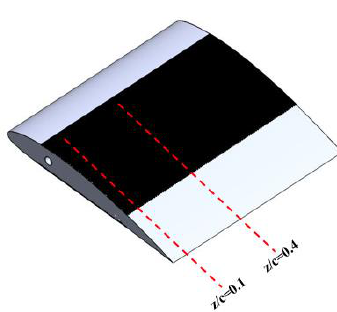
Fig. 2. Sketch of the measurements line.